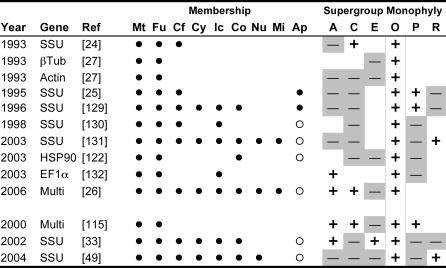
Support for Membership and Supergroup Monophyly from “Opisthokonta”-Targeted Molecular GenealogiesMember taxa: Mt, Metazoa; Fu, Fungi; Cf, Choanomonada; Cy, chytrids; Ic, Ichthyosporea (DRIPs); Cl, Corallochytrium; Nu, Nucleariida; Mi, Ministeria; Ap, apusomonads. The position of apusomonads, Ap, was not considered when scoring the monophyly of “Opisthokonta” as this organism is highly variable, and it has been removed from recent classifications (see text). See Figure 4 for further notes. References cited in this figure are [24–27,33,49,115,122,129–132].